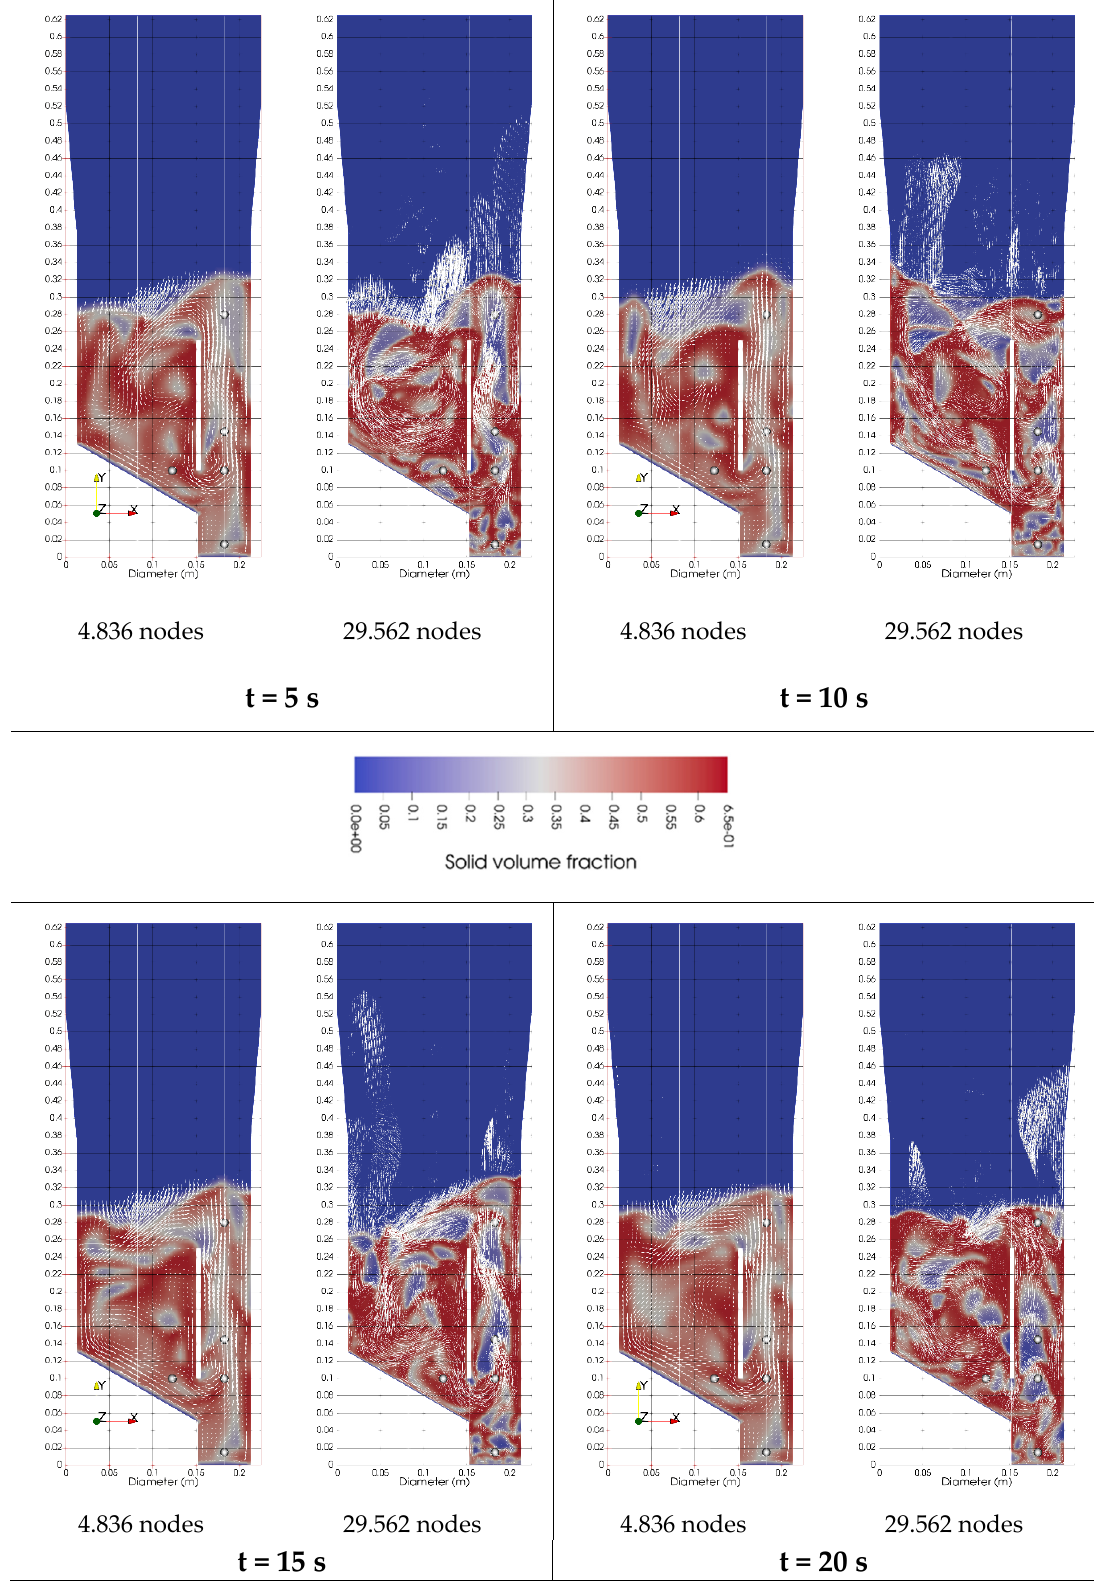
Figure 9. Solid phase volume fraction and field velocity comparison between CFD solutions with different grid refinement and at various simulation time.